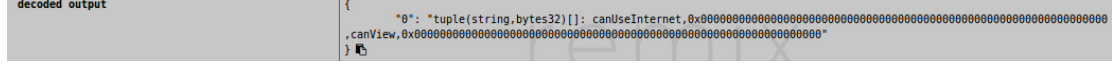
Figure 11. Blockchain denying the